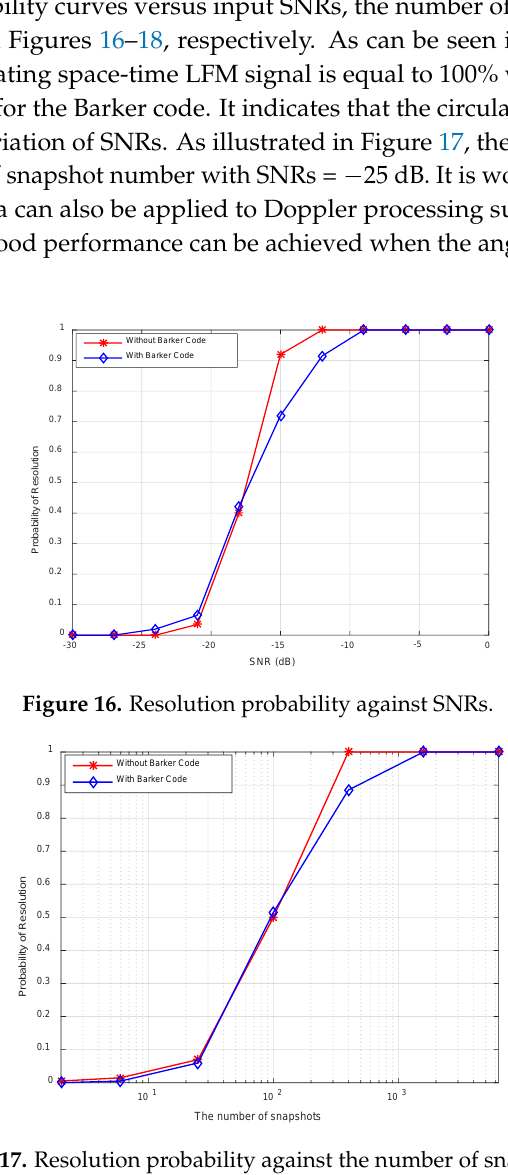
Figure 17. Resolution probability against the number of snapshots.